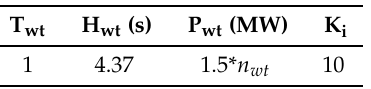
Table 1. Constants for the implementation of synthetic inertia. n wt represents the number of wind turbines with synthetic inertia control.